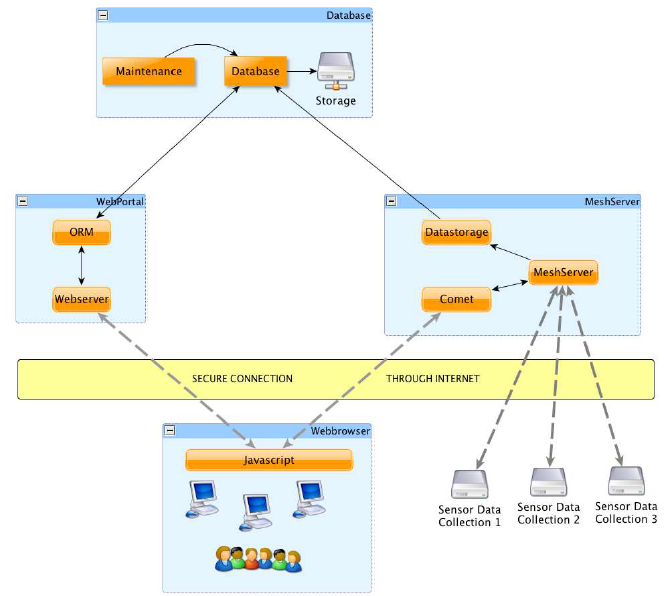
Figure 6. The SUMAC server